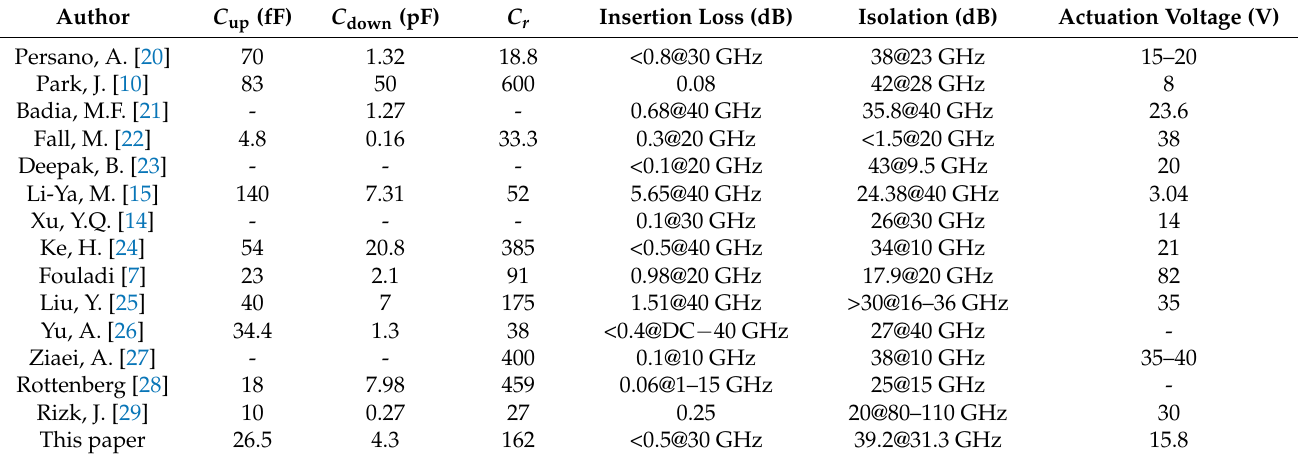
Table 3. Comparison of developed capacitive RF-MEMS switches. Adapted with permission from ref. [16]. Copyright 2020, Springer